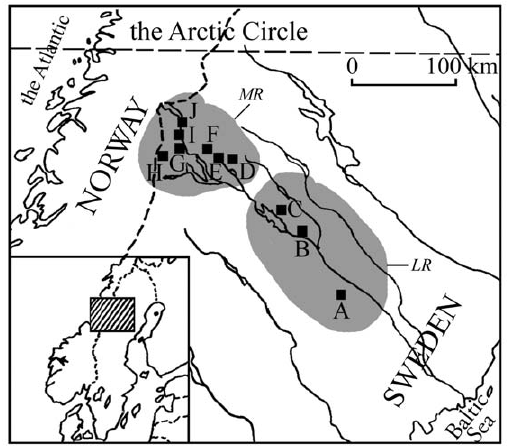
Figure 2. Agabusbipustulatus collecting areas A – J and their spatial relationship to the two main sample regions. The Lowland region (LR) and mountain region (MR) in the upper Ume river valley mountain region in northern Sweden are marked